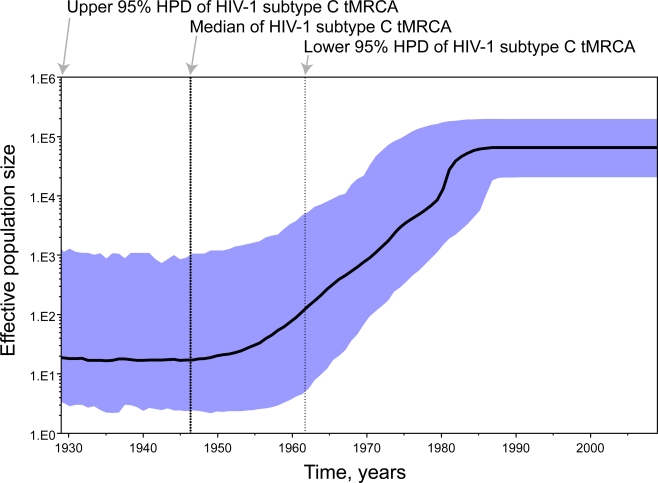
Bayesian skyline plot of HIV-1 subtype C. The upper 95% HPD, median, and lower 95% HPD of HIV-1 subtype C are projected on the time line. The bold black line traces the inferred median effective population size over time with the 95% HPD shaded in blue.